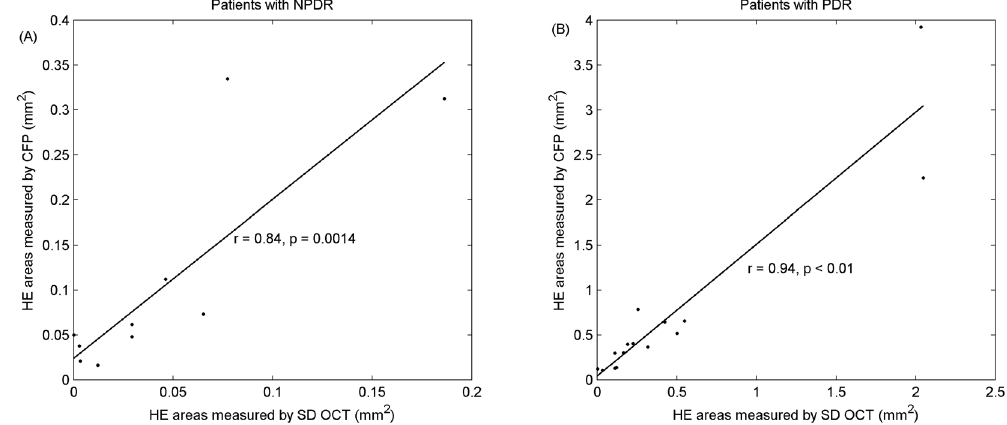
Figure 5. Results of agreement evaluation for hard exudates between CFP and SD OCT. Correlations between HE areas measured by SD OCT and CFP at NPDR and PDR are displayed as ( A ) and ( B ),